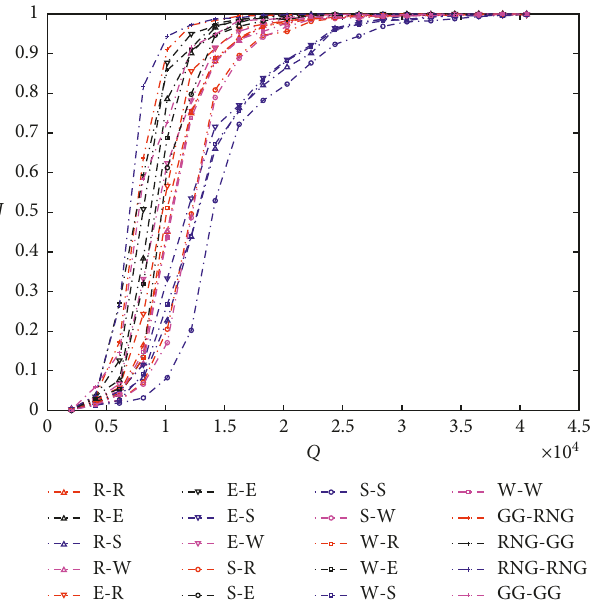
Figure 8: Completely coupled multilayer network performance as the total traffic flow increases.